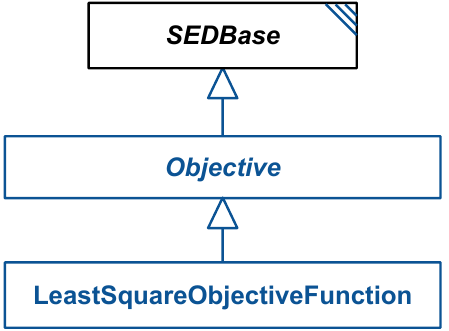
Figure 2.16: The SED-ML Objective and LeastSquareObjectiveFunction